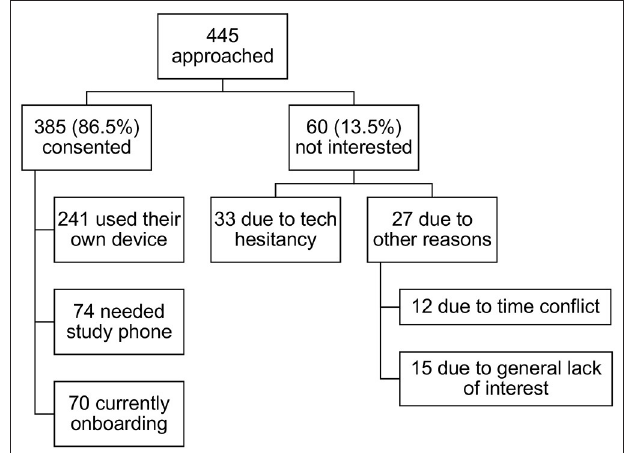
FIGURE 4 | ARC study enrollment rates.